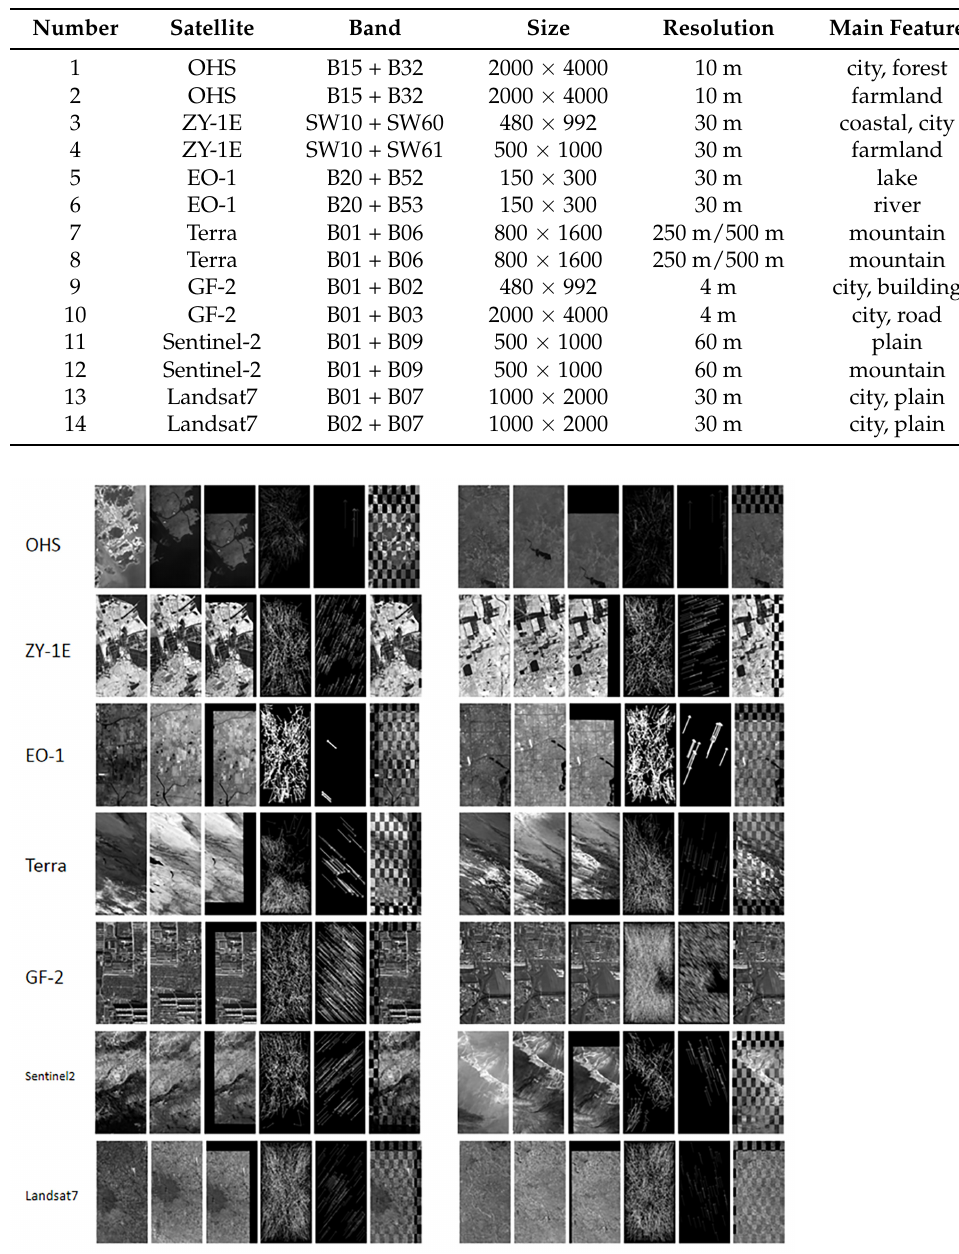
Figure 9. Interband registration results of 14 sets of experimental data. Each row shows one type of satellite data, and each row shows two sets of experiments. In each set of registration results, from left to right are the target image, the original image, the registered image, the putative matching motion field, the motion field of feature points after the feature matching, and the combined checkboard results of the target image and the registered